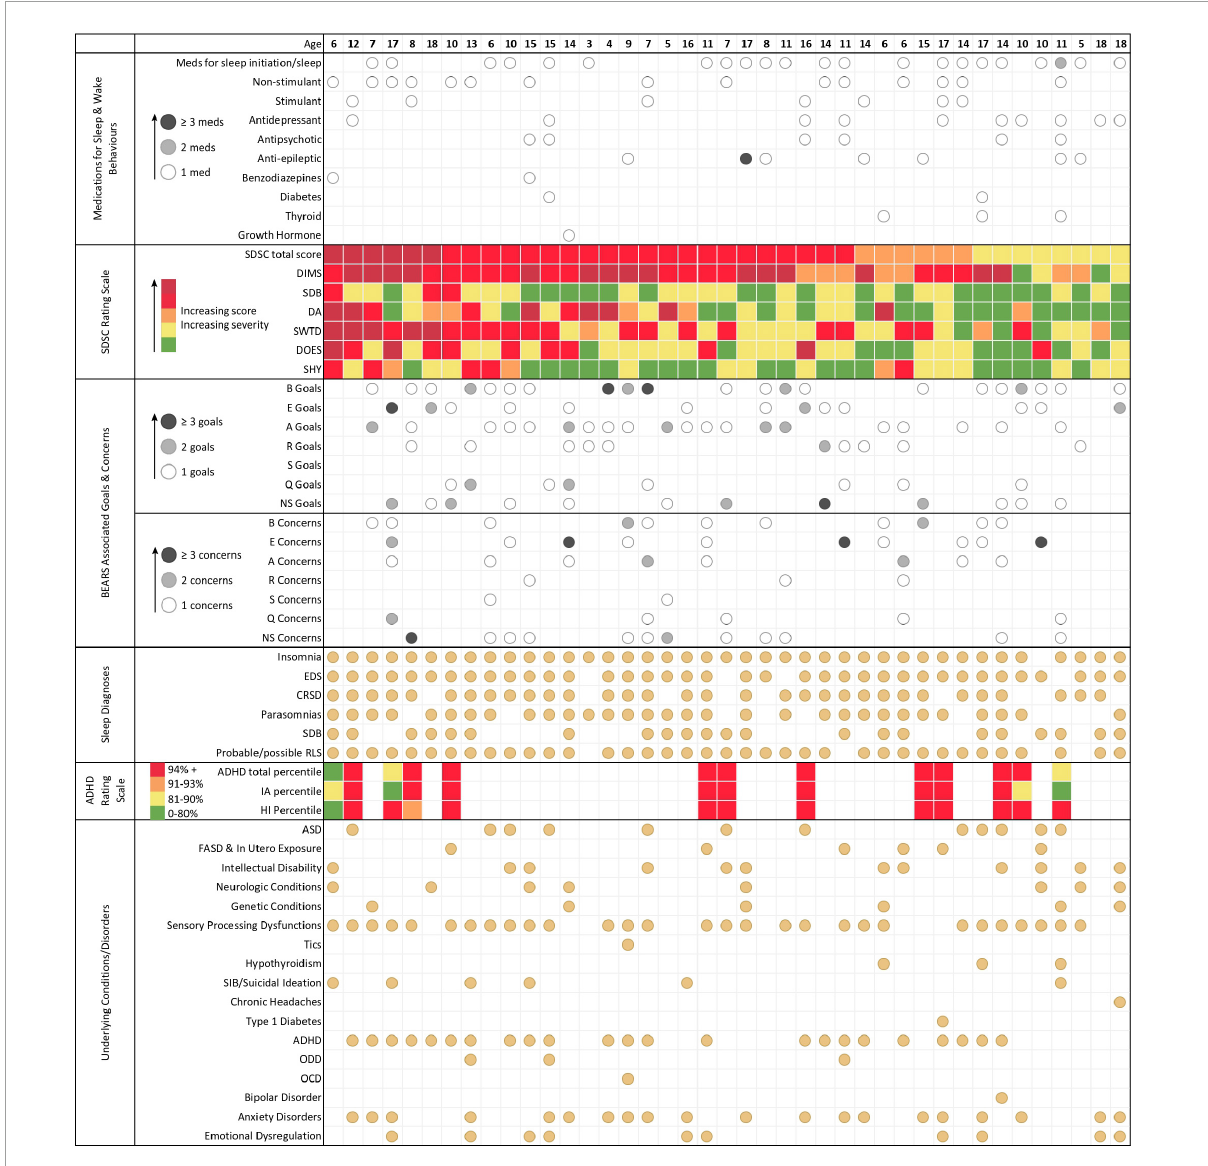
FIGURE2 An overview of intake data. Each column represents the data for one individual patient. Patients are arranged according to SDSC total score (highest scores from the left. From the top to the bottom: MEDICATION DATA. Medications have been grouped according to categories (e.g., sleep initiation/sleep; non-stimulant, etc.). One medication is marked with a white circle, two medications are marked with a grey circle, and three or more medications are marked with a black circle. Note that melatonin (using international terminology) is listed as a medication and not as an over the counter drug. SDSC TOTAL SCORES AND SUBSCORES. DIMS, disorders of initiating and maintaining sleep; SDB, sleep disordered breathing; DA, disorders of arousal; SWTD, sleep-wake transition disorders; DOES, disorders of excessive somnolence; SHY, sleep hyperhidrosis. Each coloured dot represents a different category of SDSC scoring that increases (and severity of symptoms) from green (lowest score), to yellow, to amber, to red, and finally dark red (highest score). GOALS/CONCERNS. Information on goals and concerns of the patients has been grouped using the BEARS themes. SLEEP DIAGNOSES. The sleep medicine working diagnoses, which were made after the first assessment, are presented in the lowest block. EDS, excessive daytime sleepiness; CRSD, circadian rhythm sleep disorder; SDB, sleep disordered breathing; RLS, restless legs syndrome. ADHD Scores. IA, inattention and HI, hyperactivity-impulsivity sub-scores. Note that ADHD scoring was only available in 13 patients.